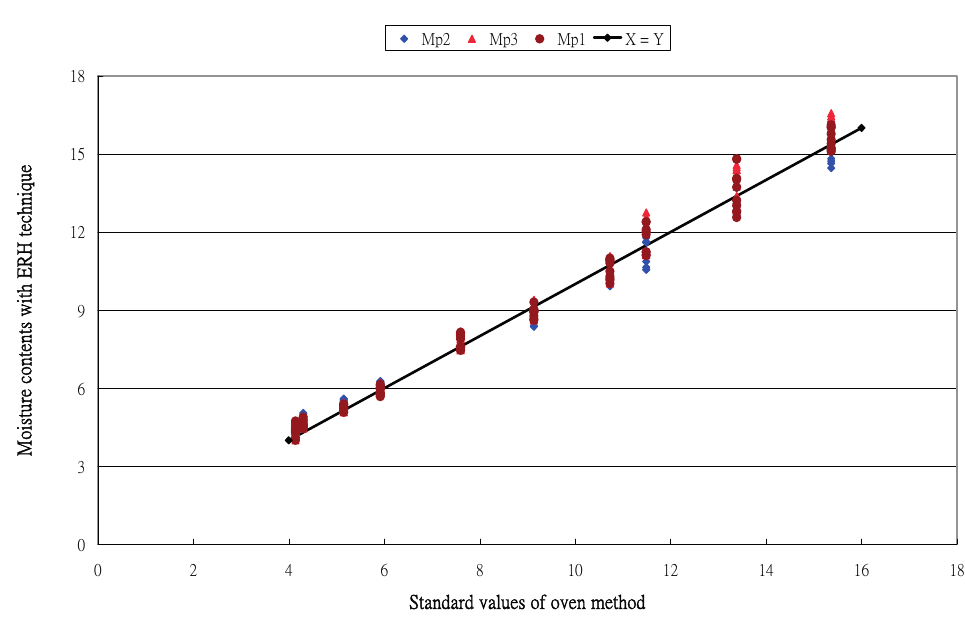
Figure 5. Comparison of the moisture contents using the ERH technique and standard values using the oven method.